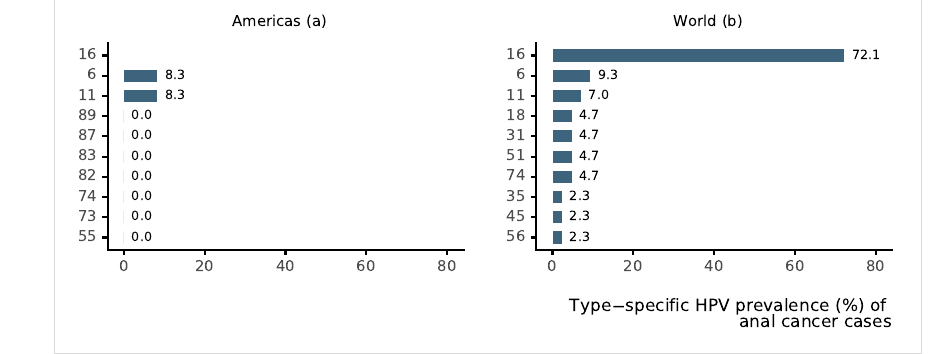
Figure 63: Comparison of the ten most frequent HPV types in AIN 2/3 cases in Americas and the